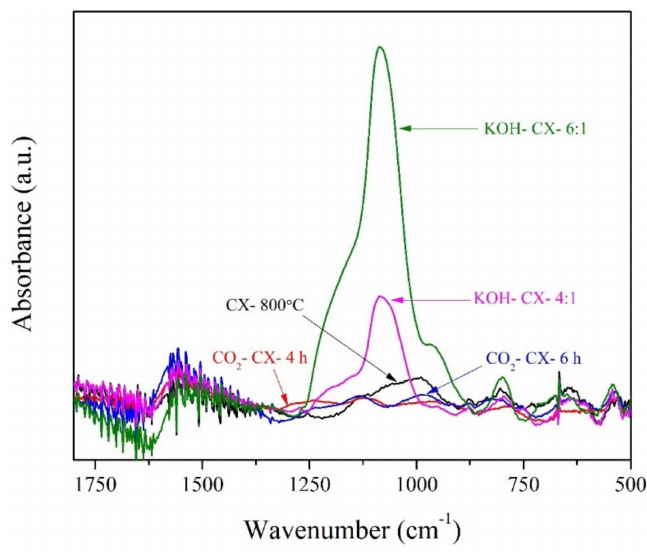
Figure 10. FTIR spectra of CX and its activated